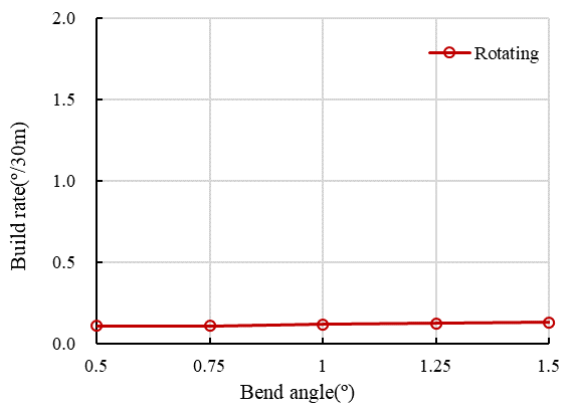
Fig. 19. Rotating build rate VS bend angle respectively. While the well diameter is 311.5mm.